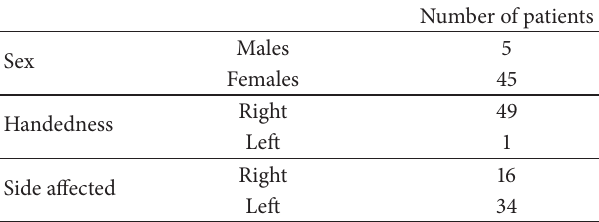
Table 1: Demographics of study group ( 𝑛 = 50 ).